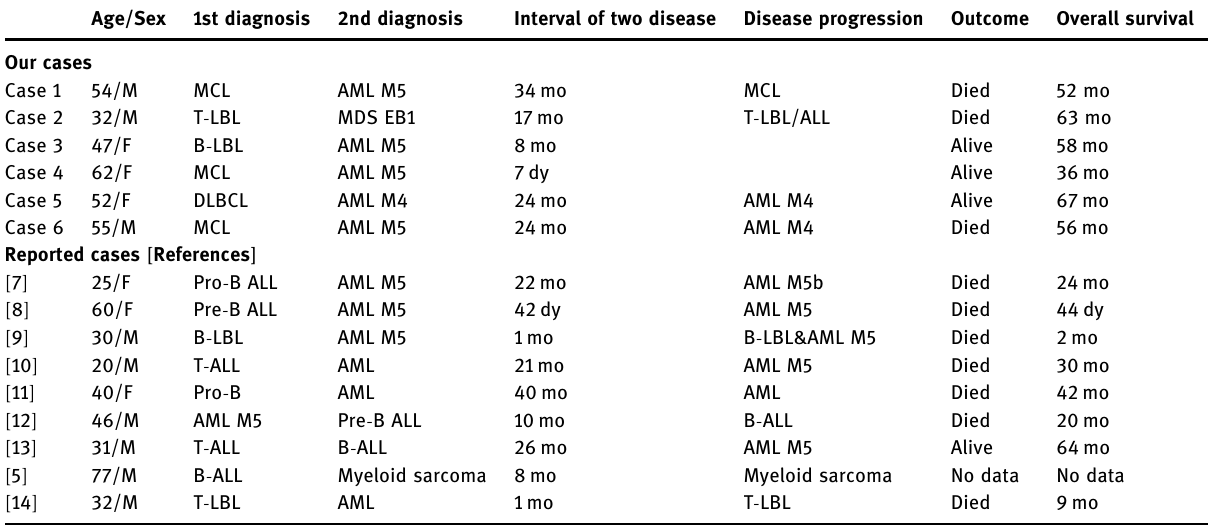
Table 1: Characteristics of our cases and reported cases Age/Sex 2nd